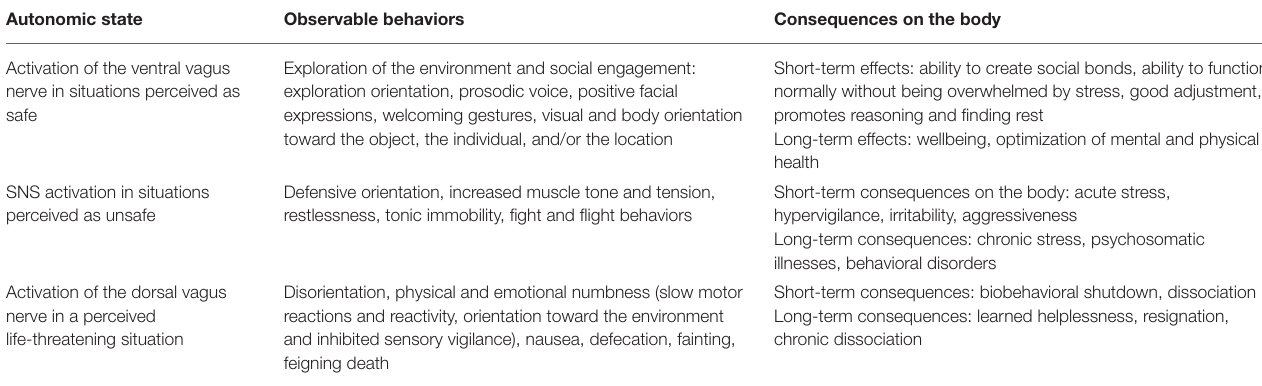
TABLE 2 | Examples of observable behaviors based on three types of autonomic regulation and their consequences for the organism. Autonomic state Observable behaviors Consequences on the body Activation of the ventral vagus nerve in situations perceived as